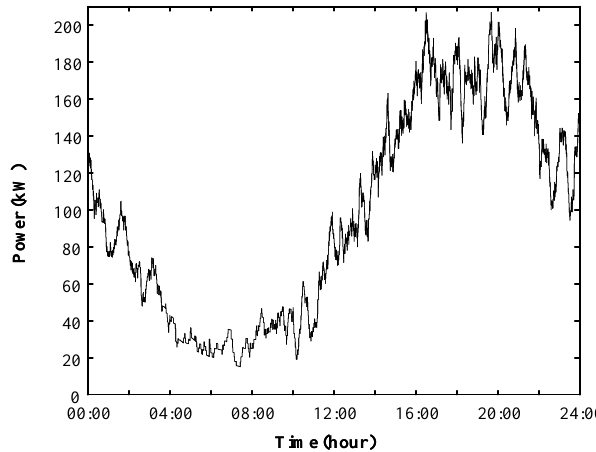
Figure 4. Two thousand domestic electric water heaters’ daily power consumption curve.